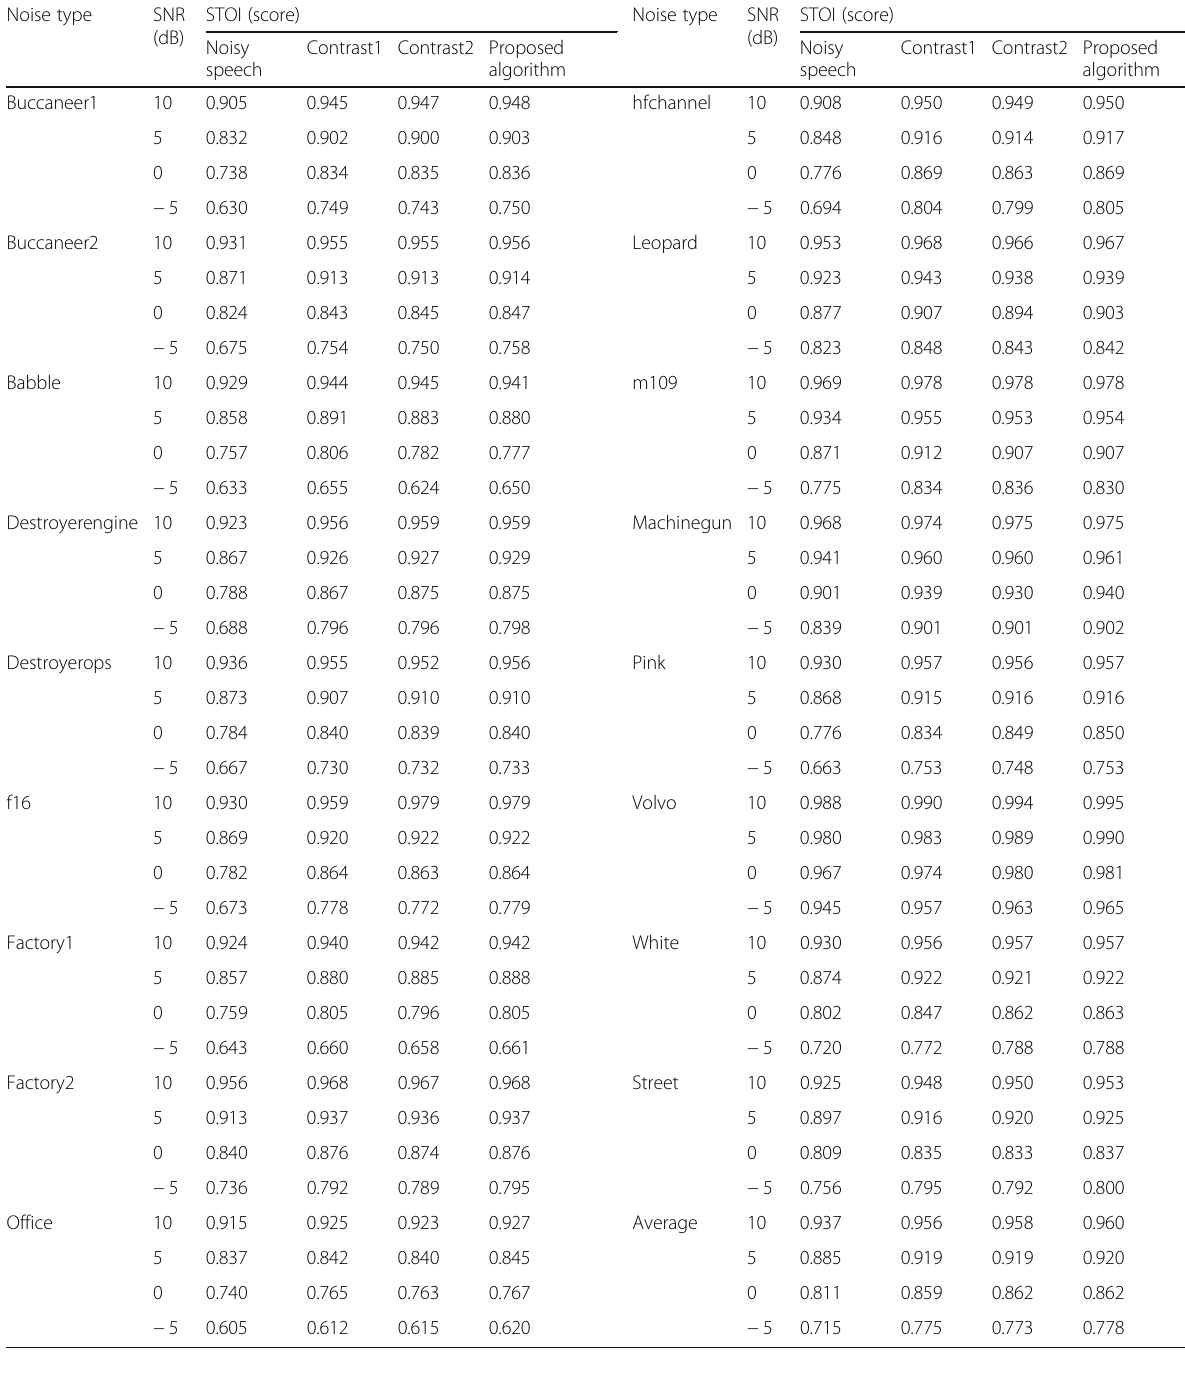
Table 4 The STOI of the proposed algorithm and the contrast algorithm Noise